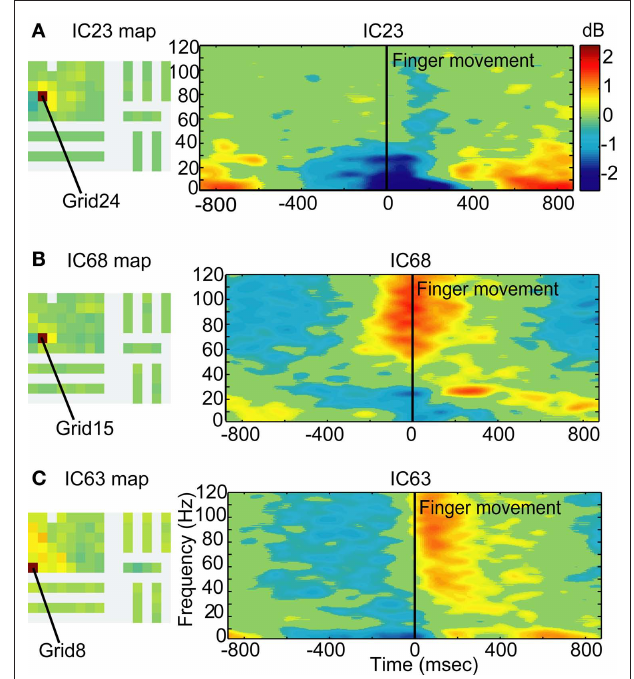
FIGurE 10 | Independent components capture separable dynamics in different regions of motor cortex Grid maps and event-locked log power spectra for three independent components. (A) The grid map of IC23 projects most strongly to Grid23 (red), located over or near Brodmann Area 6 of the pre-central gyrus, and also projects to neighboring electrodes. IC23 demonstrates an alpha and beta power decrease time-locked to the finger movement, followed by a rebound power increase. (B) The grid map of IC68 projects most strongly to Grid15 (red), also over or near Brodmann Area 6. As compared to IC23, the movement-locked beta power decrease is smaller in amplitude. IC68 additionally demonstrates a broadband gamma power increase time-locked to the movement but with less precision in time than IC18 ( Figure 9 ). (C) The grid map for IC63 projects most strongly to Grid8 (red), near the superior temporal gyrus and bordering on Area 43 of the pre-central gyrus. The event-locked spectral dynamics demonstrate a broadband gamma power increase within 100 ms after finger movement onset.